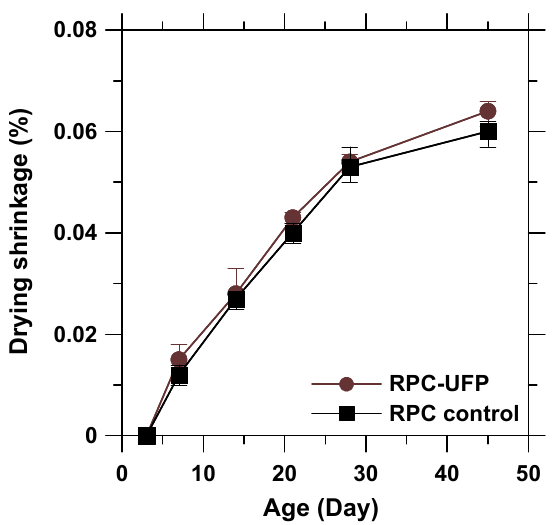
Figure 6. Drying shrinkage of reactive powder concrete (RPC) control and RPC-UFP.